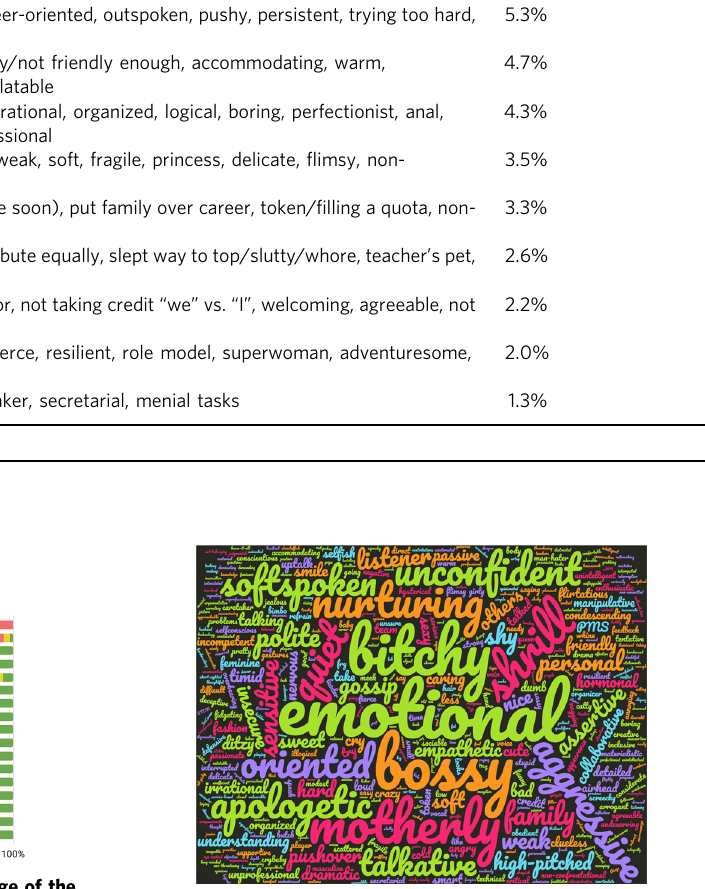
Fig. 2 Word cloud showing most commonly occurring words and phrases elicited via focus groups. The larger the word, the more frequently it appeared in the